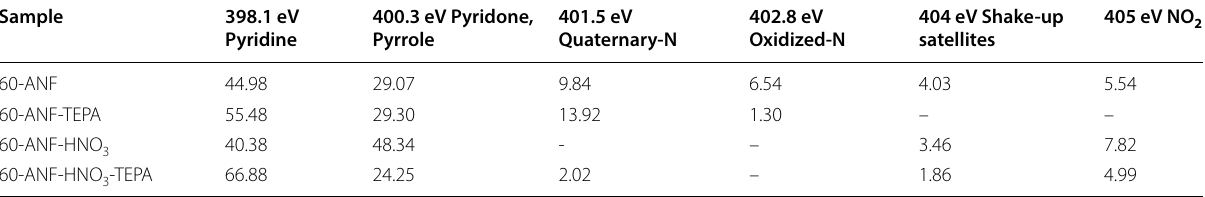
Table 4 Quantitative results of the deconvoluted XPS N Sample 398.1 eV